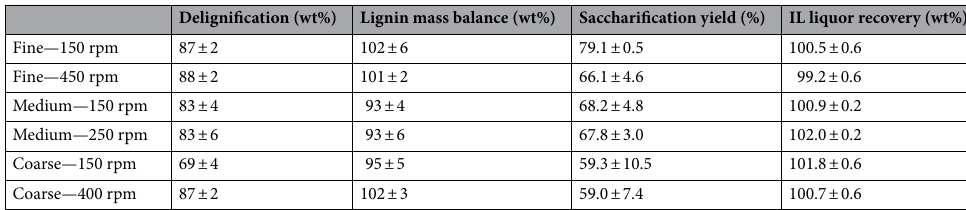
Table 6. Key pretreatment outcomes at 10 mL vs 1 L scale as a function of stirring speed a . a Selected stirring speeds: 150 rpm and maximal stirring speed that can be achieved for a particular experiment (250–450